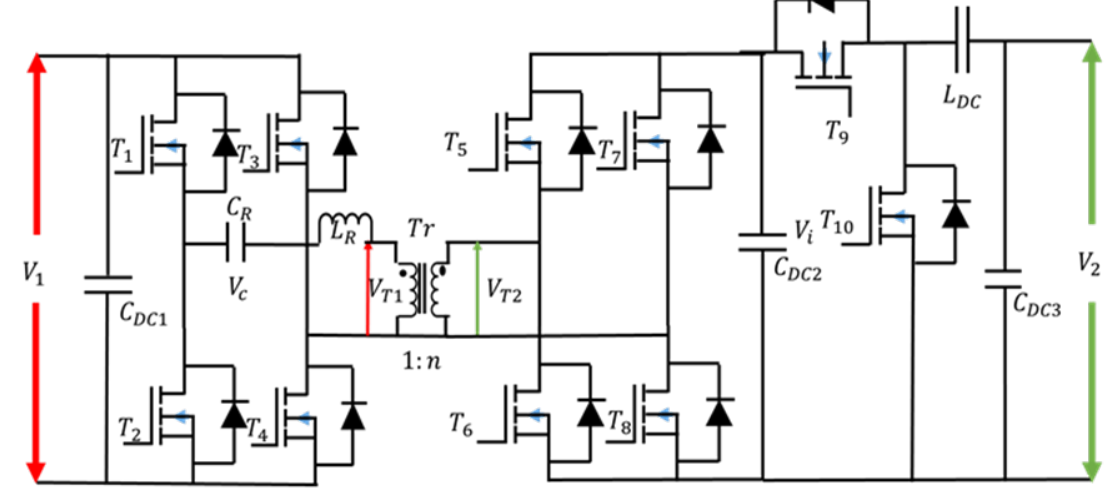
Figure 3. Two-stage SRC